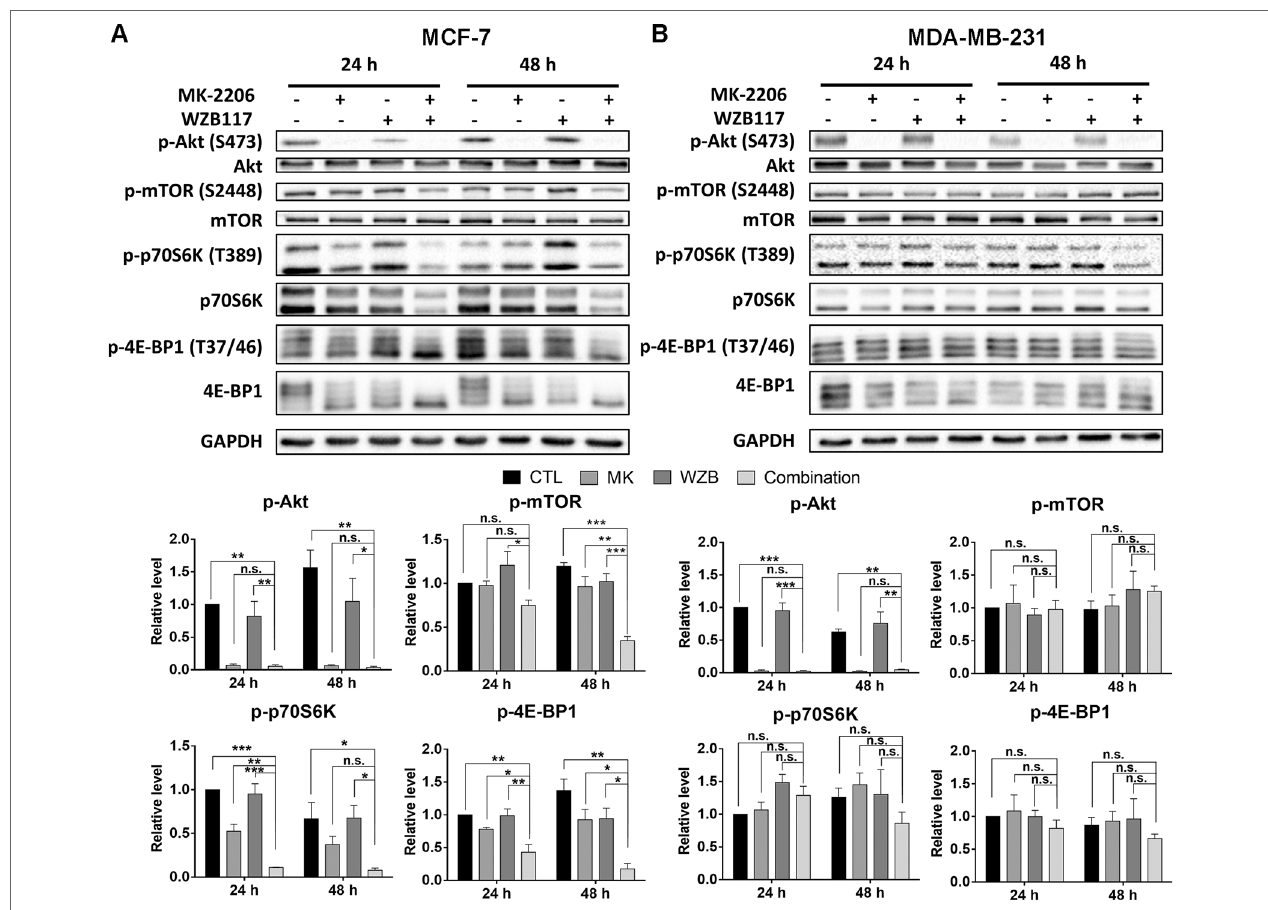
FIGURE 4 | The effect of MK-2206 and WZB117 on proteins involved in the Akt/mTOR signaling pathway. (A) MCF-7 cells. (B) MDA-MB-231 cells. MCF-7 cells were treated with 6 μM MK-2206 and 60 μM WZB117, and MDA-MB-231 cells were treated with 12 μM MK-2206 and 60μM WZB117, either alone or in combination, for 24 or 48 h. Cells were then harvested for Western blot analysis. Quantitative data are presented as the mean ± SEM of three independent experiments. *P < 0.05; **P < 0.01; ***P < 0.001; n.s., not significant (P > 0.05).